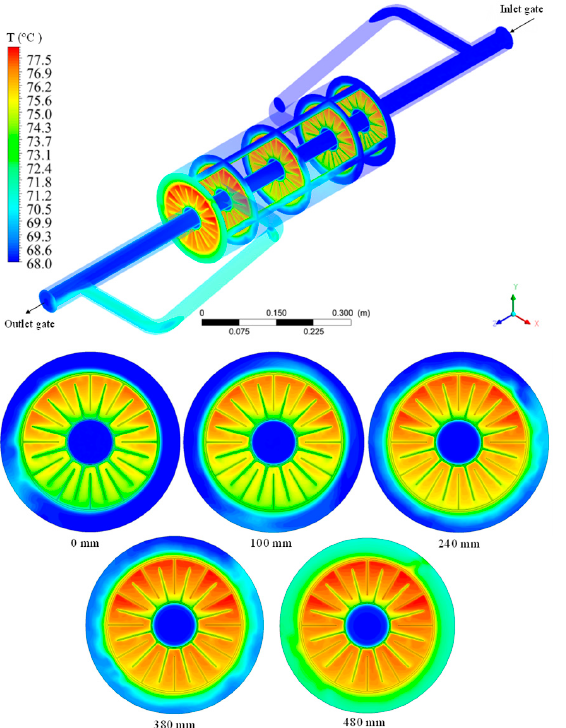
Figure 10. Temperature distribution in TTHX domains for 80% of the PCM in a liquid state (t = 4942 s).